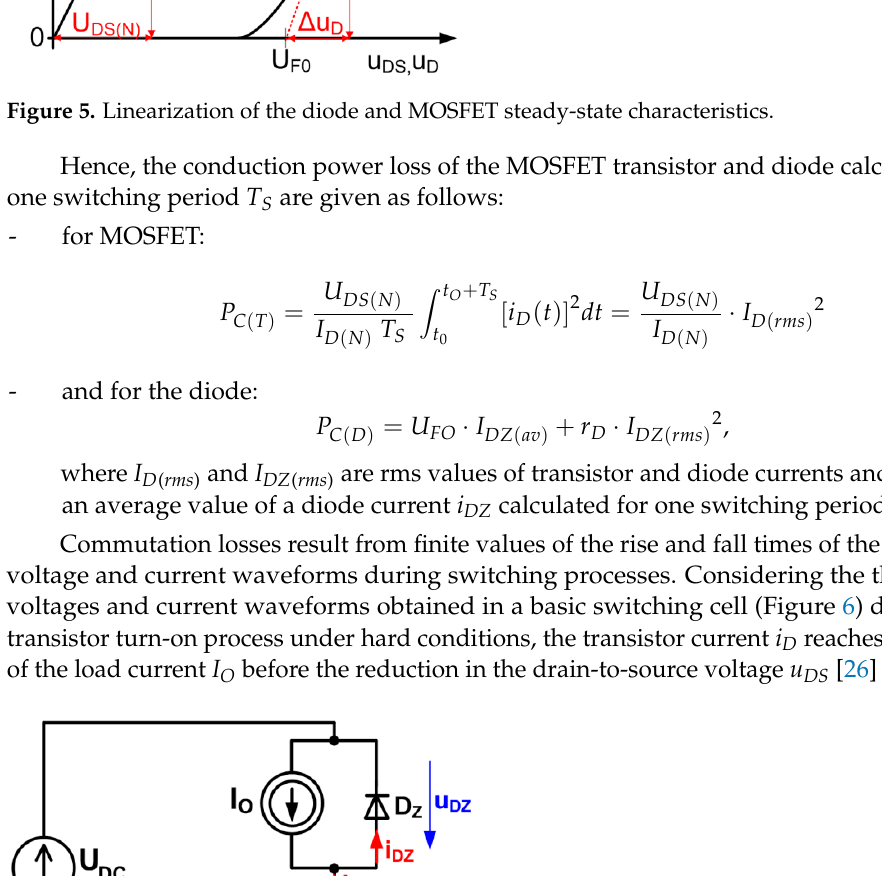
Figure 5. Linearization of the diode and MOSFET steady-state characteristics.